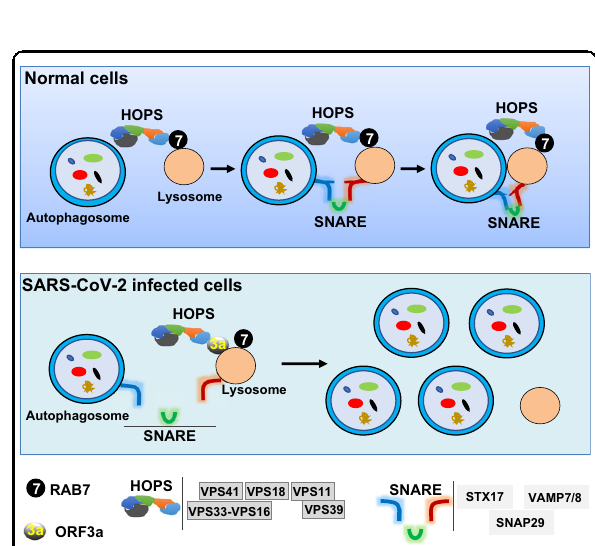
Fig. 6 Schematic diagram of the function of SARS-CoV-2 ORF3a in blocking autophagosome – lysosome fusion. Upper, after double- layered autophagosomes are formed, they fuse with lysosomes for fi nal degradation of their cargoes. GTPase RAB7 recruits the tethering HOPS complex, acting as a bridge to bring the two compartments together. These tethering HOPS complexes, in turn, help SNAREs physically drive the fusion of opposing lipid bilayers. Lower, when host cells are subjected to SARS-CoV-2 infection, ORF3a is expressed and interacts with VPS39. The ORF3a – VPS39 interaction sequesters VPS39, preventing its interaction with RAB7 and resulting in failure of HOPS – RAB7 assembly and blockage of autophagosome – lysosome fusion, which eventually leads to accumulation of